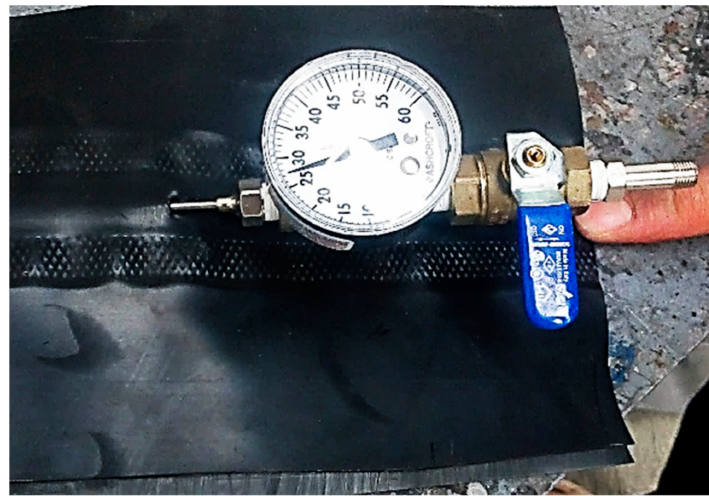
Figure 4. Air pressure test carried out in channel that leaves thermofusion machinery.